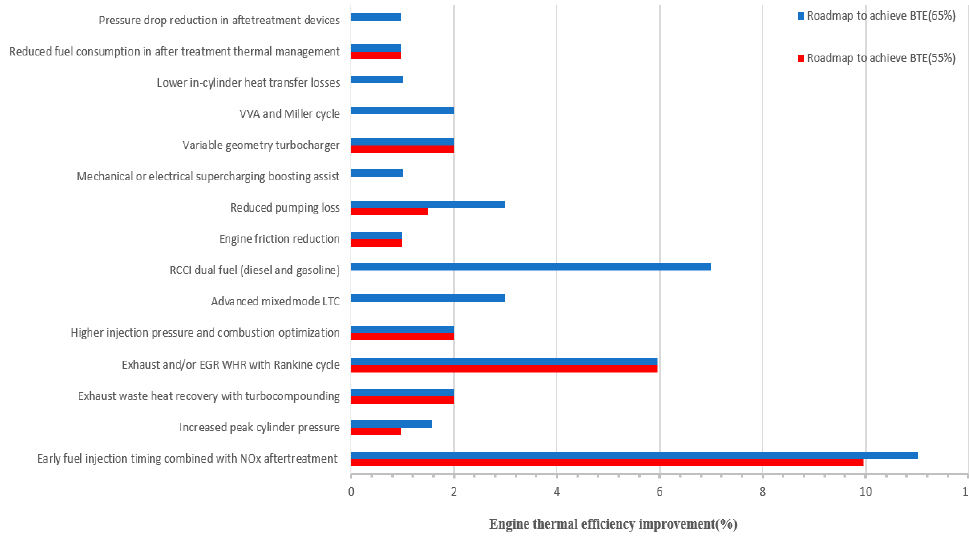
Figure 21. Thermal engine efficiency improvement technologies of diesel engines [6] .